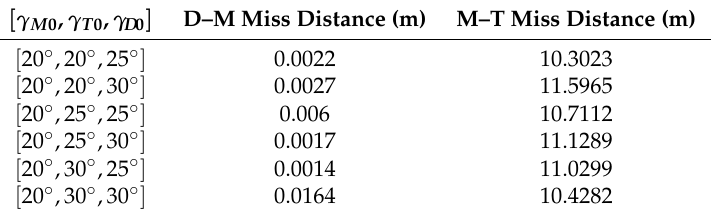
Table 1. Simulation results with different flight-path angles. D—defender; M—missile; T—target.